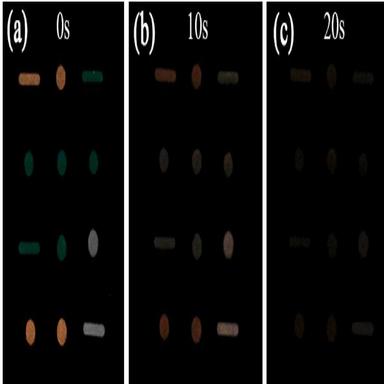
(a) The appearances of afterglow signals for the designed logos after heating at 150 ◦C for (a) 0s, (b) 10s and (c) 20s.